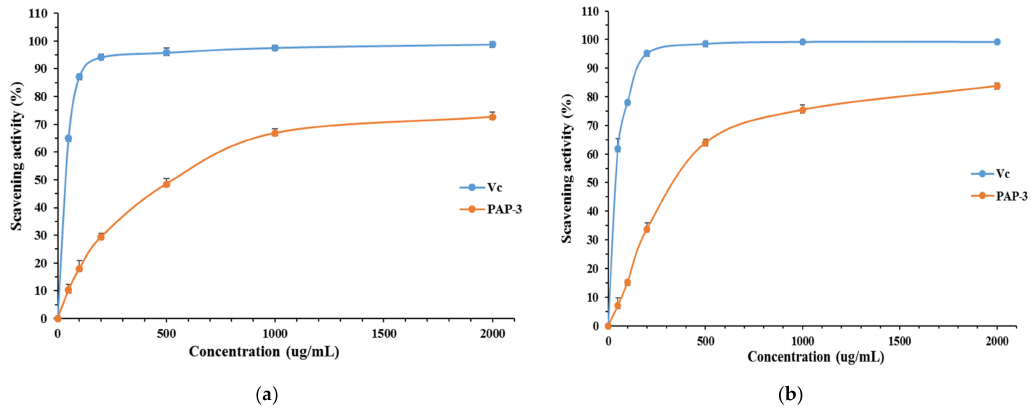
Figure 7. Scavenging activity of DPPH ( a ), ABTS ( b ) free radicals of PAP-3 from P. aquilinum